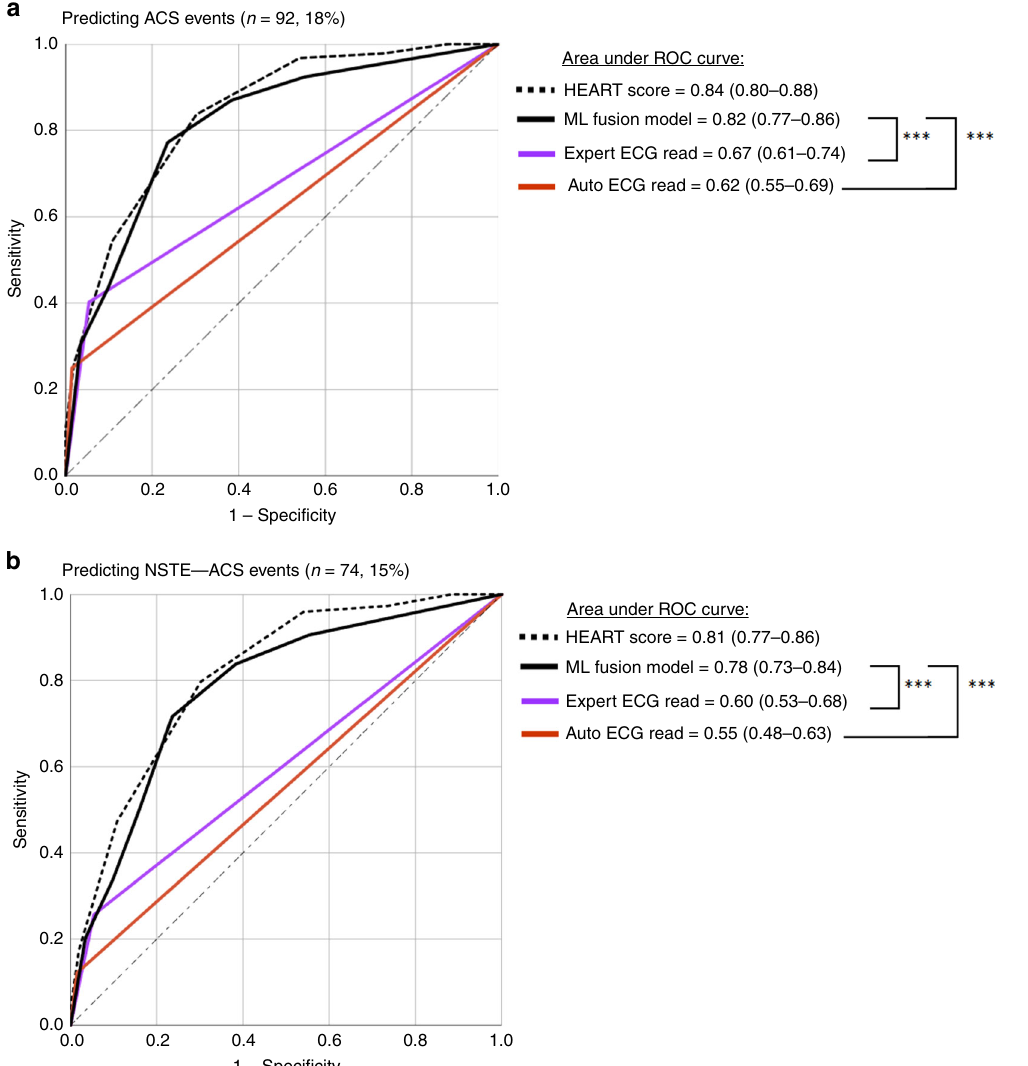
Fig. 3 Classi fi cation performance of fi nal model on testing set ( n = 499). This fi gure compares the area under ROC curve (95% con fi dence interval) between our machine learning (ML) fusion model against experienced clinicians and against rule-based commercial interpretation software for detecting a any acute coronary syndrome (ACS) event, and b non-ST elevation acute coronary syndrome events (NSTE-ACS). *** p < 0.001 using two-sided DeLong ’ s nonparametric approach.